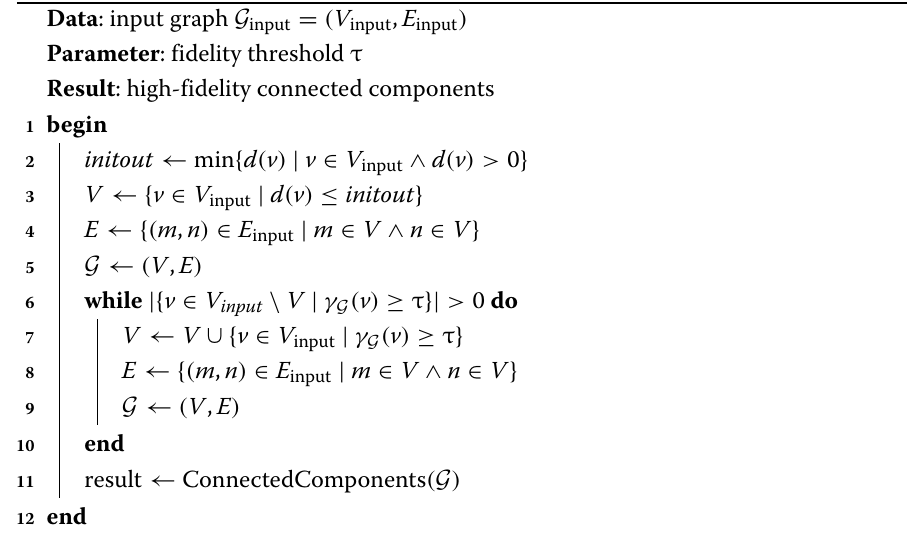
Algorithm 1: High-fidelity Component Selection